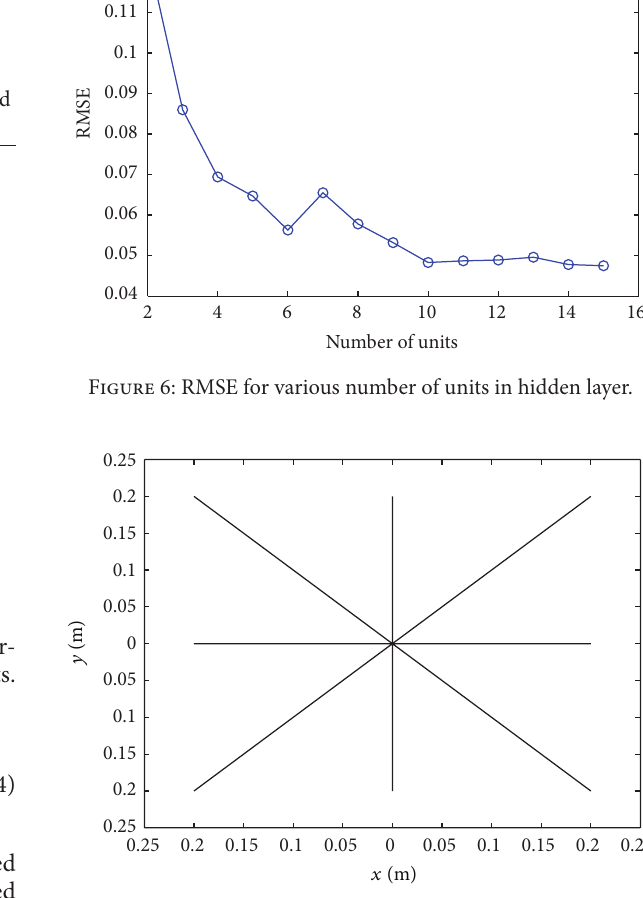
Figure 7: Motion path for exploratory